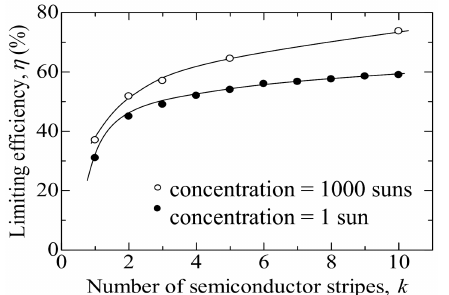
Figure 13. Limiting energy conversion e ffi ciency of the MOP 3 SC (Reproduced from [38], the union of ecodesigners,